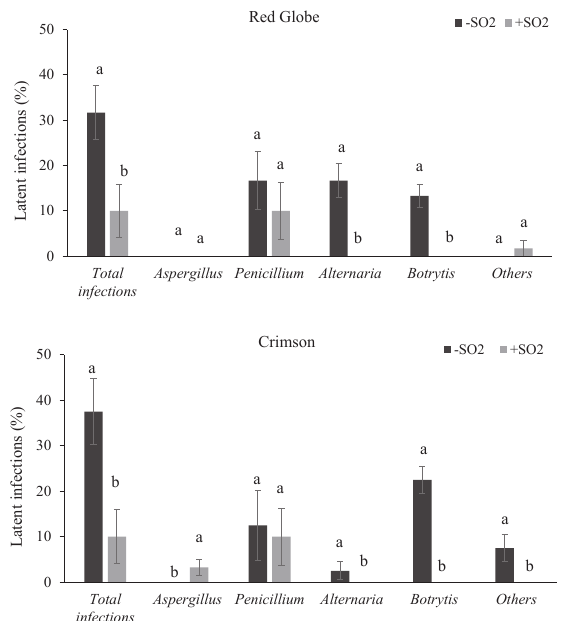
Figure 2. Mean proportions (%) of latent fungal infections on ‘Red Globe’ and ‘Crimson’ table grapes, stored either with (+SO 2 ) or without (black histograms, -SO 2 ) SO 2 pads, after three month of storage. For each variable, columns accompanied by different letters are significantly different ( P ≤ 0.05). Bars represent standard errors of mean, each from three replicates.